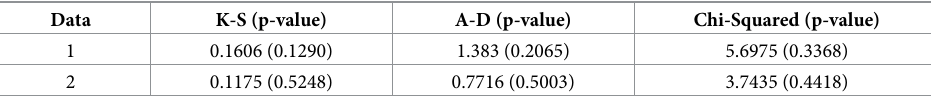
Table 17. Test statistic and p-value associated with each test for example 2. Data